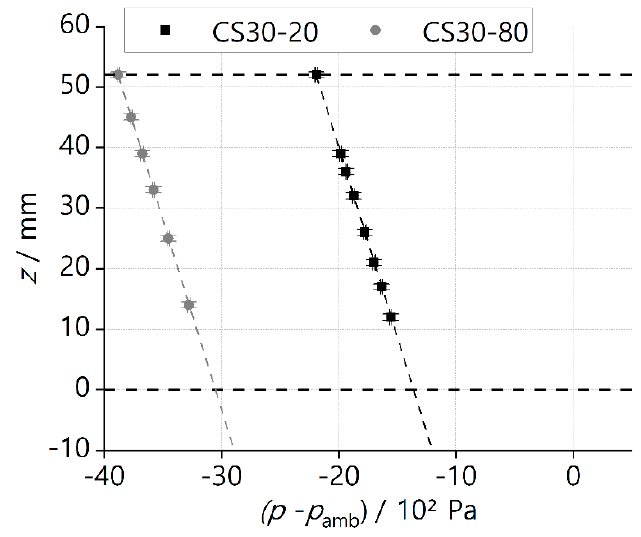
Figure 9. Experimental data (symbols) and calculated hydrostatic head (dotted lines, Equation (14)) from phase − separation experiment at different flow rates for samples with 30 wt% of solid loading. Details corresponding to each data point are given in Tables 7 and 8. The vertical error bar for height measurement z is ± 0.5 mm and the horizontal error bar for pressure difference ( p − p amb ) is ± 0.1 hPa.